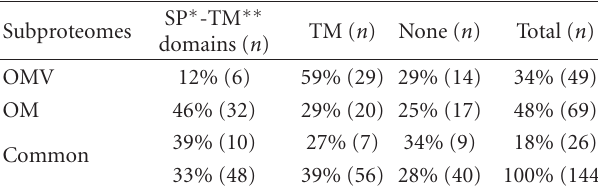
Table 1: Summary of OMV and OM